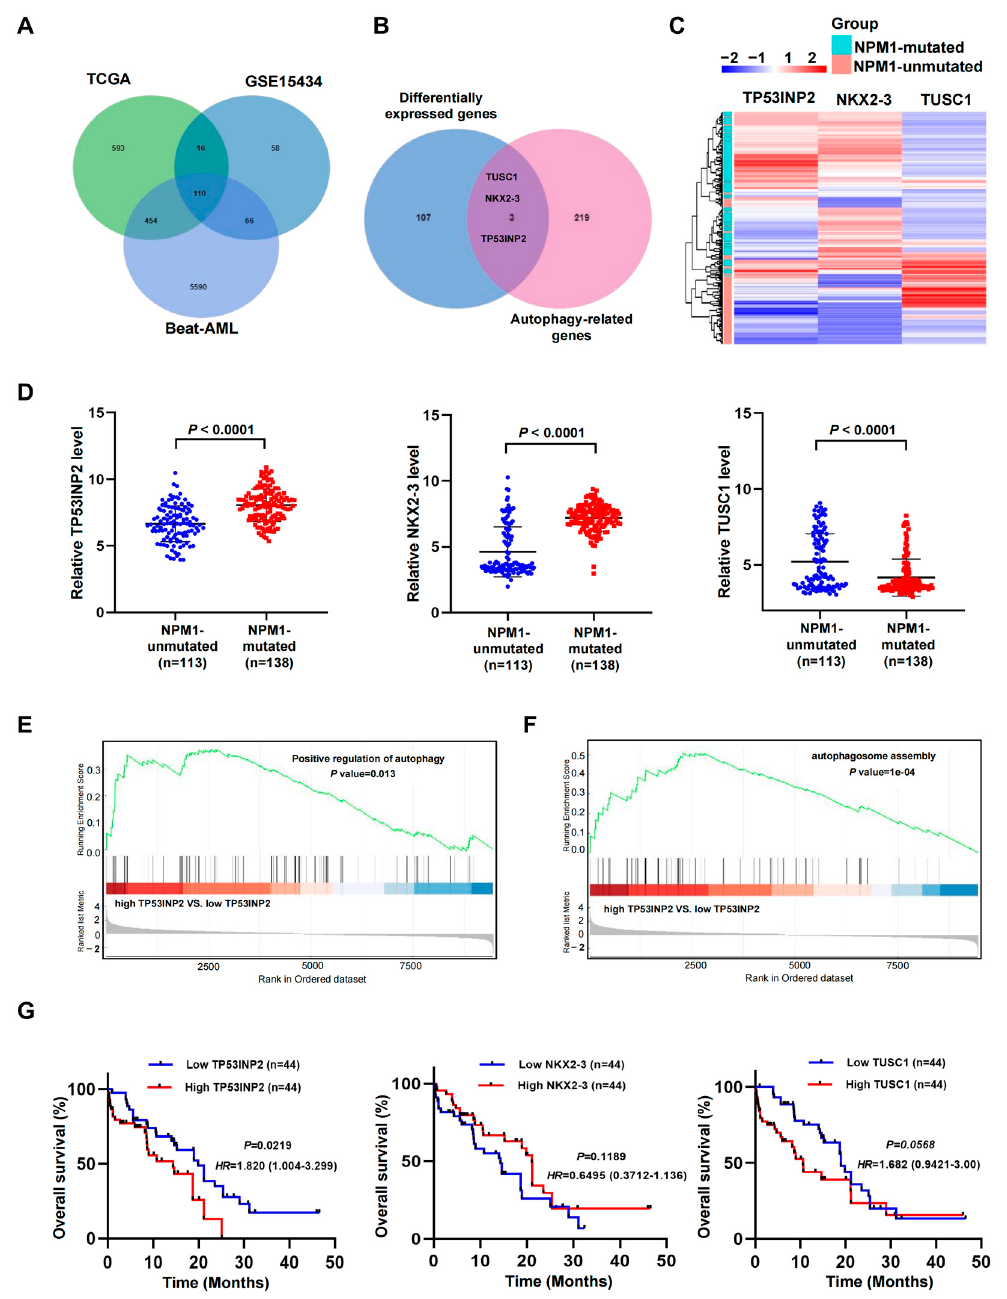
Figure 1. Identification of the autophagy-related genes in NPM1 -mutated AML. ( A ) Venn diagram showing the overlap among the differentially expressed genes ( NPM1 -mutated AML vs NPM1 -unmutated AML) obtained from three public datasets (TCGA, GSE15434, and Beat-AML). ( B ) Venn diagram showing the overlap among the differentially expressed genes and autophagy-related genes. ( C ) Heatmaps of TP53INP2 , NKX2-3 , and TUSC1 genes in AML patients with NPM1 mutations and without NPM1 mutations from GSE15434 ( n = 251) datasets. ( D ) The expression patterns of TP53INP2 , NKX2-3 , and TUSC1 transcripts in NPM1 -mutated AML cases compared to NPM1 -unmutated AML cases from GSE15434 datasets. ( E , F ) GSEA plots showing differential enrichment of genes related to autophagosome reassembly and positive regulation of autophagy. The data were from Beat- AML. ( G ) Survival analysis based on TP53INP2 , NKX2-3 , and TUSU1 mRNA expression level in primary NPM1 -mutated AML samples of Beat-AML. Survival analysis was conducted by the use of Kaplan–Meier